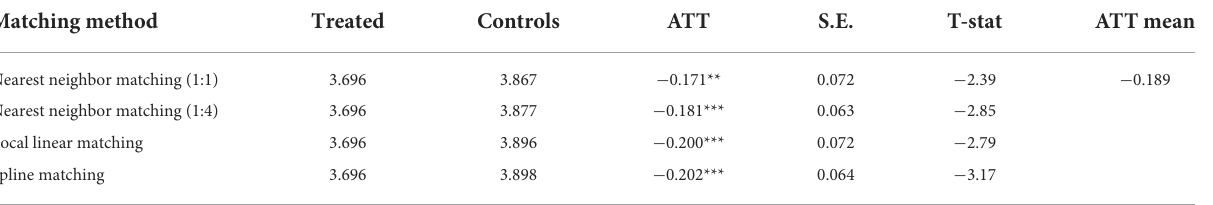
TABLE 3 Matching results of scores of different